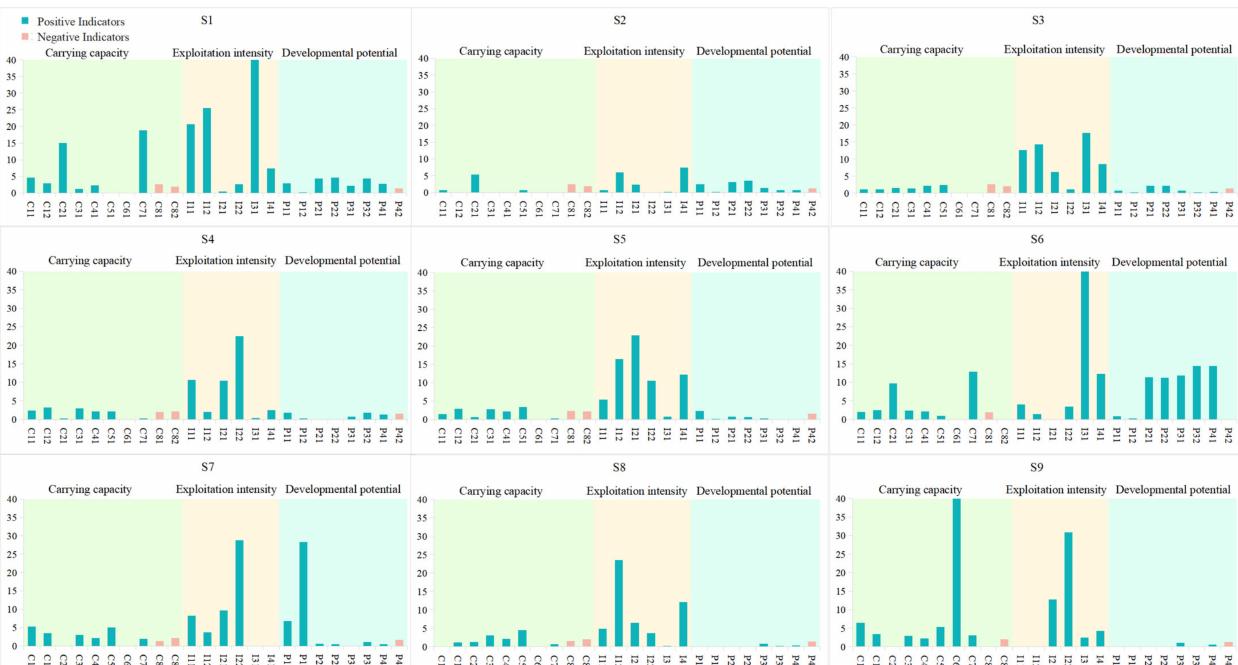
Figure 5. Product of standardization value of indicators and